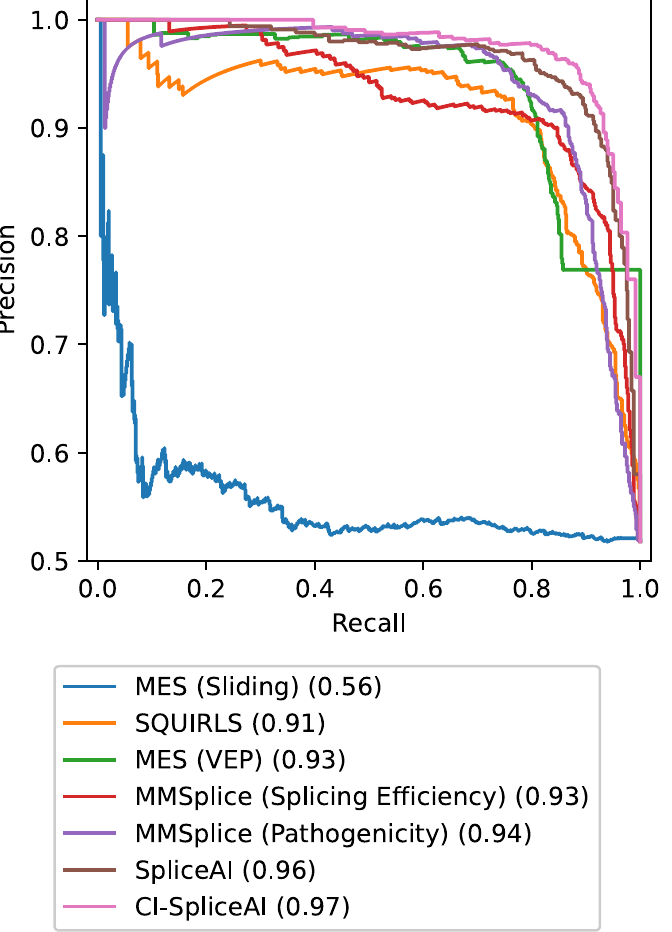
Fig 6. PR curves of algorithms investigated on all 1,316 variants. PR curves demonstrate the capabilities of a model to trade off precision and recall. The area under each curve is indicated in the legend.